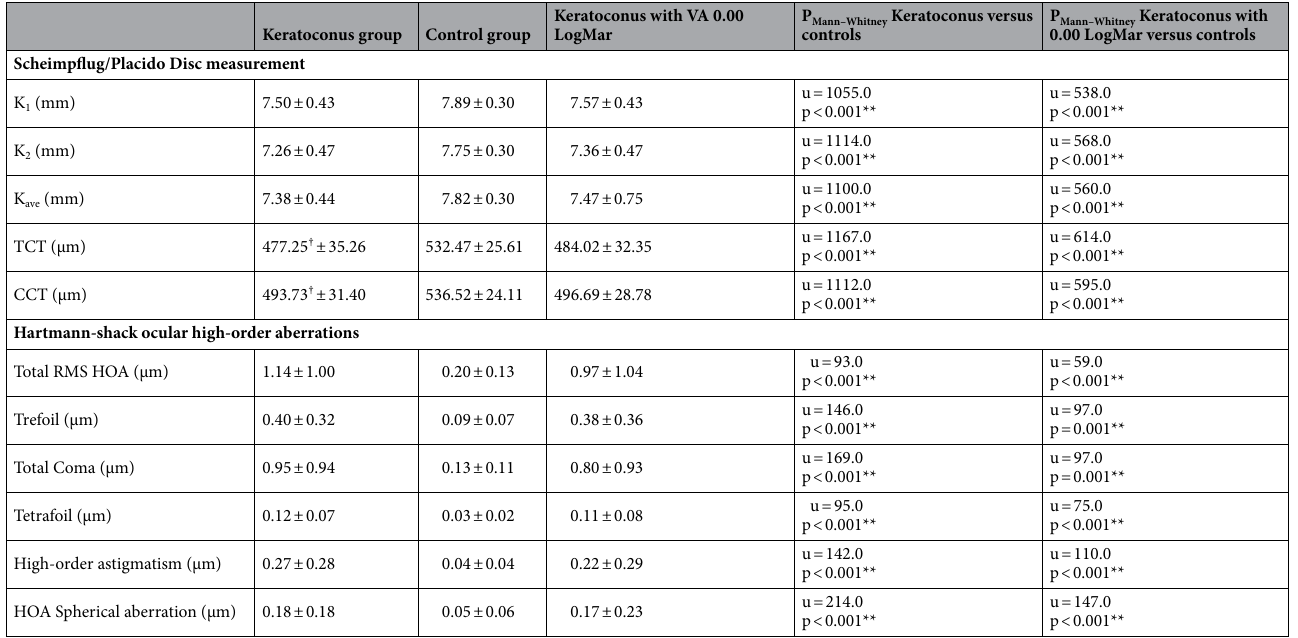
Table 2. Corneal parameters and ocular higher-order aberrations for keratoconus group, keratoconus subjects with visual acuity of 0.00 LogMar and for control group. *Significant level of < 0.05, **significant level of < 0.005. † One subjects did not have good Scheimpflug pictures for 1 keratoconus suspect eye, therefore central corneal thickness and thinnest corneal thickness are average results for 37 eyes (not 38). VA, visual acuity; K, keratometry; CCT, central corneal thickness; TCT, thinnest corneal thickness; RMS, root mean square; HOA, higher-order aberrations; µm, micrometer.